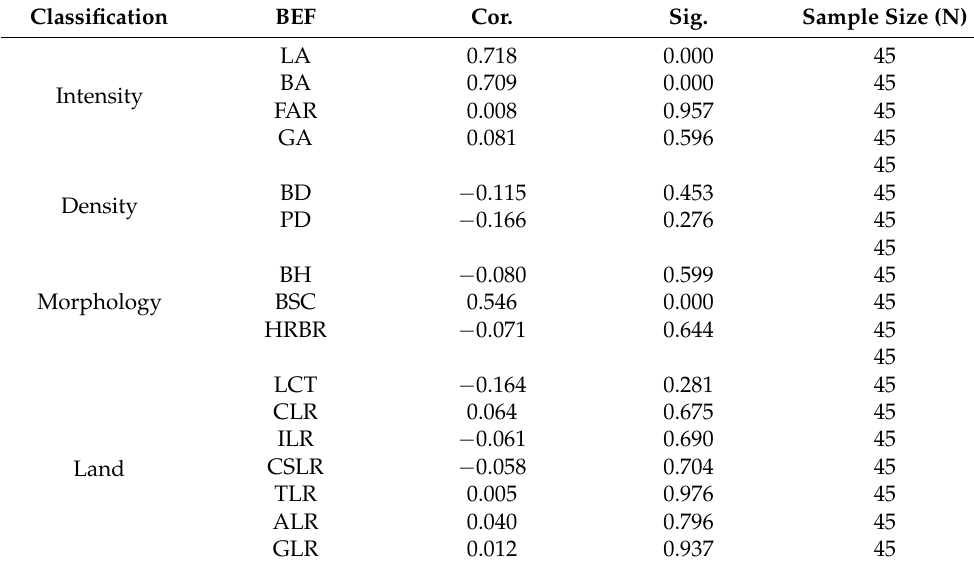
Table 5. Detailed information of the Pearson correlation coefficient.